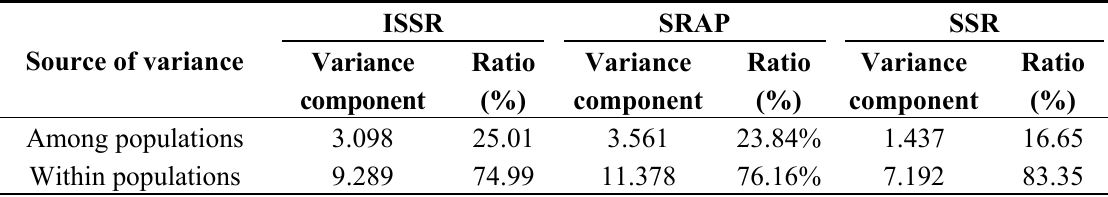
ISSR SRAP SSR Variance Ratio Variance Ratio Variance component (%) component (%) component A p value < 0.001 was considered